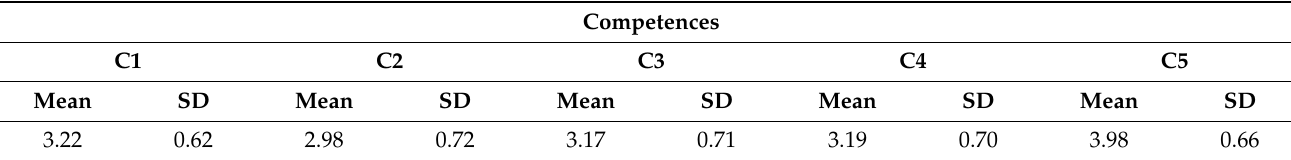
Table 5. Mean and standard deviation of competences.